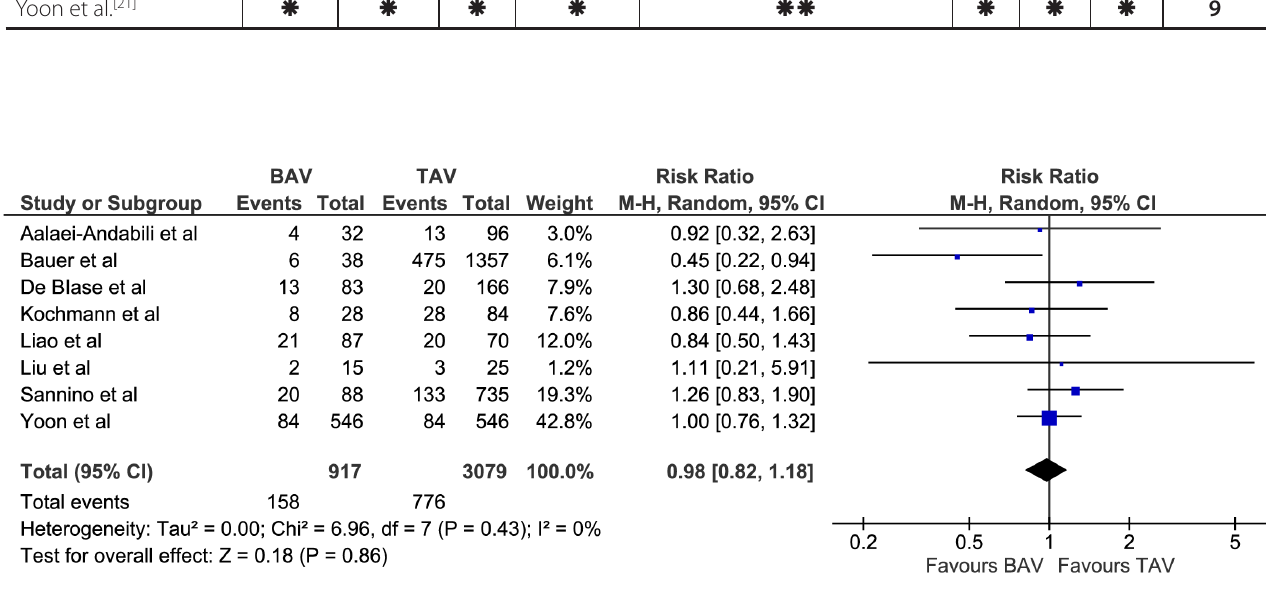
Fig. 4 - Forest plot for postoperative permanent pacemaker requirement. BAV=bicuspid aortic valve; CI=confidence interval; M-H=Mantel- Haenszel; TAV=tricuspid aortic valve